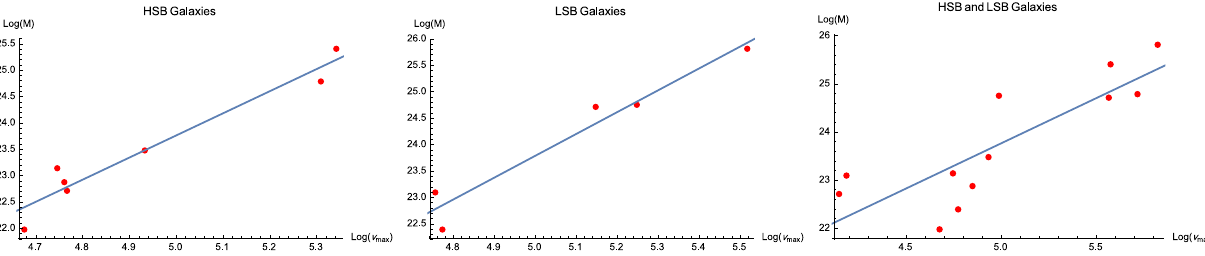
Fig. 2 The baryonic Tully–Fisher relation of 12 spiral galaxy samples [5]. The rotation velocity at quasi flat region v qf is given in the units of km/s and mass is in units 10 10 M sun . The red-dots are the results